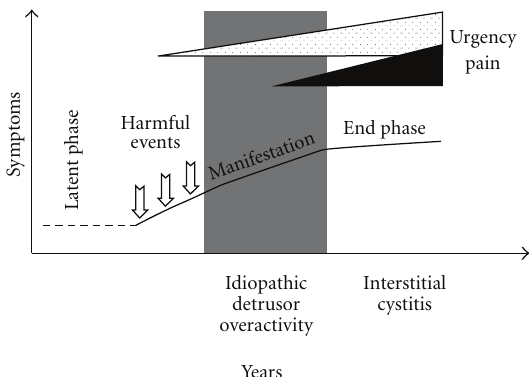
Figure 1: Hypothetical course of BPS/IC development. While urge- ncy develops in early “manifestation” phase,pain symptomsbecome evident only in late “end” phase, defining full-blown